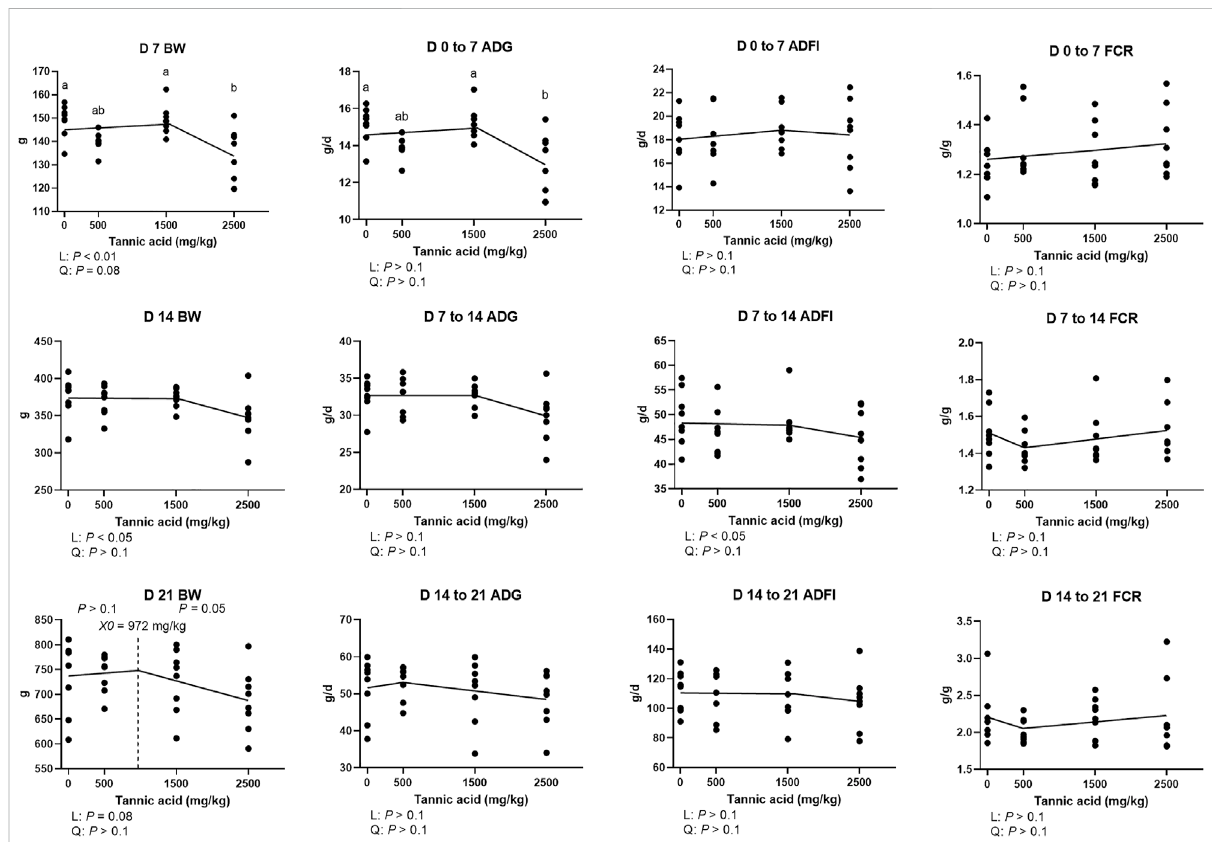
FIGURE 1 Growth performance parameters (BW, ADG, ADFI, and FCR) of broiler chickens fed different concentrations (0, 0.5, 1.5, and 2.5 g/kg) of tannic acid on D 7, 14, and 21. The treatment groups were compared using one-way ANOVA followed by the Tukey ’ s multiple comparison. Different superscriptsdifferat p < 0.05. Orthogonalpolynomialcontrastsanalysis wasconducted toseelinear pattern(L)andquadraticpattern(Q)amongthe treatments.Tocalculatetheoptimaldosageoftannicacidinbroilers,segmentedlinearregressionwasconducted,and X0 (in fl ectionpoint)with p values for slope 1 (lower than X0 ) and slope 2 (higher than X0 ) were